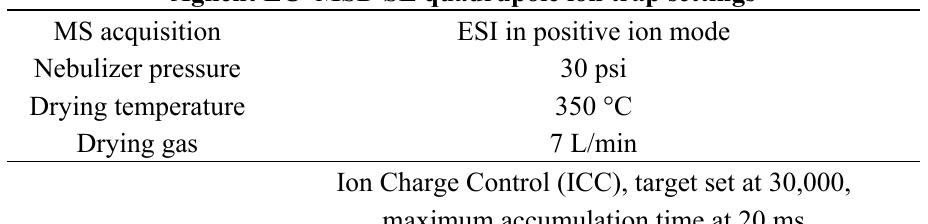
Table 1. Mass spectrometric conditions. The HPLC Agilent 1100 series was equipped with on line degasser and automatic injector coupled on-line with an Agilent 1100 LC/MSD SL quadrupole ion